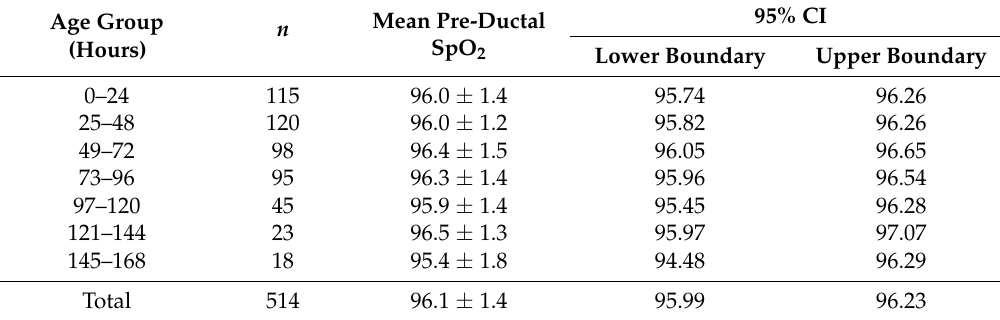
Table 6. Mean values of pre-ductal pulse SpO 2 in relation to postnatal age of